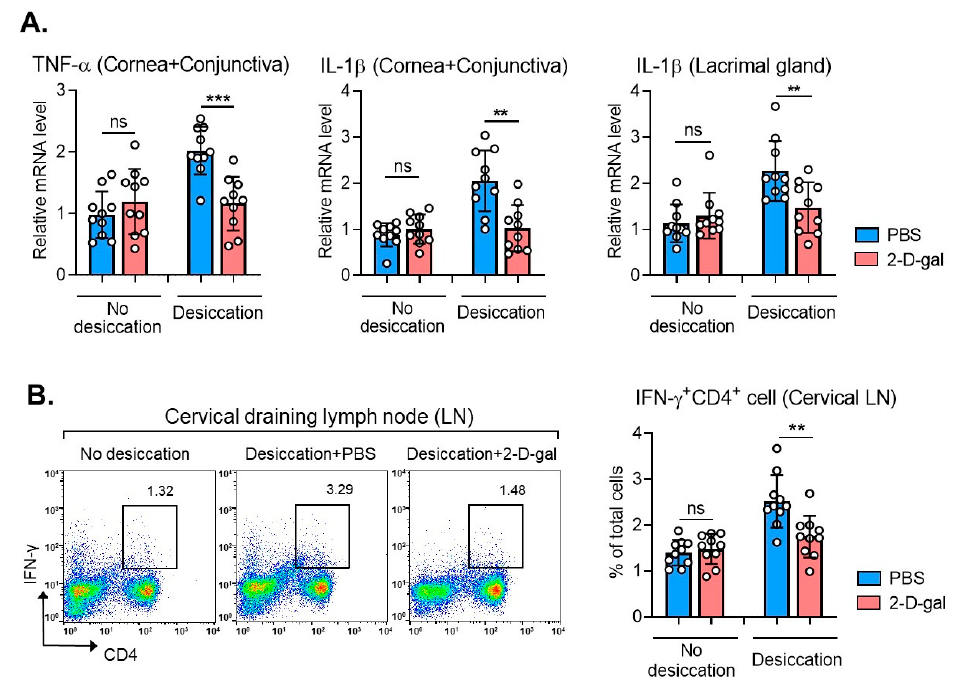
Figure 3. Effects of 2-D-gal on immune response at the ocular surface in DED. ( A ) Real-time RT-PCR analysis for TNF- α and IL-1 β in the cornea and conjunctiva or in the lacrimal gland in BALB/c mice under physiological condition (no desiccating stress) or desiccating stress with or without 2-D-gal treatment. Shown are the relative mRNA levels to normal BALB/c mice (no desiccation, no 2-D-gal). ( B ) Representative and quantitative flow cytometry results for IFN- γ + CD4 + Th1 cells in cervical draining lymph nodes (LN). Shown are the percentages of IFN- γ + CD4 + cells out of total LN cells. A circle represents the data (mean ± SD) from an individual animal. ** p < 0.01, *** p < 0.001, ns: not significant.